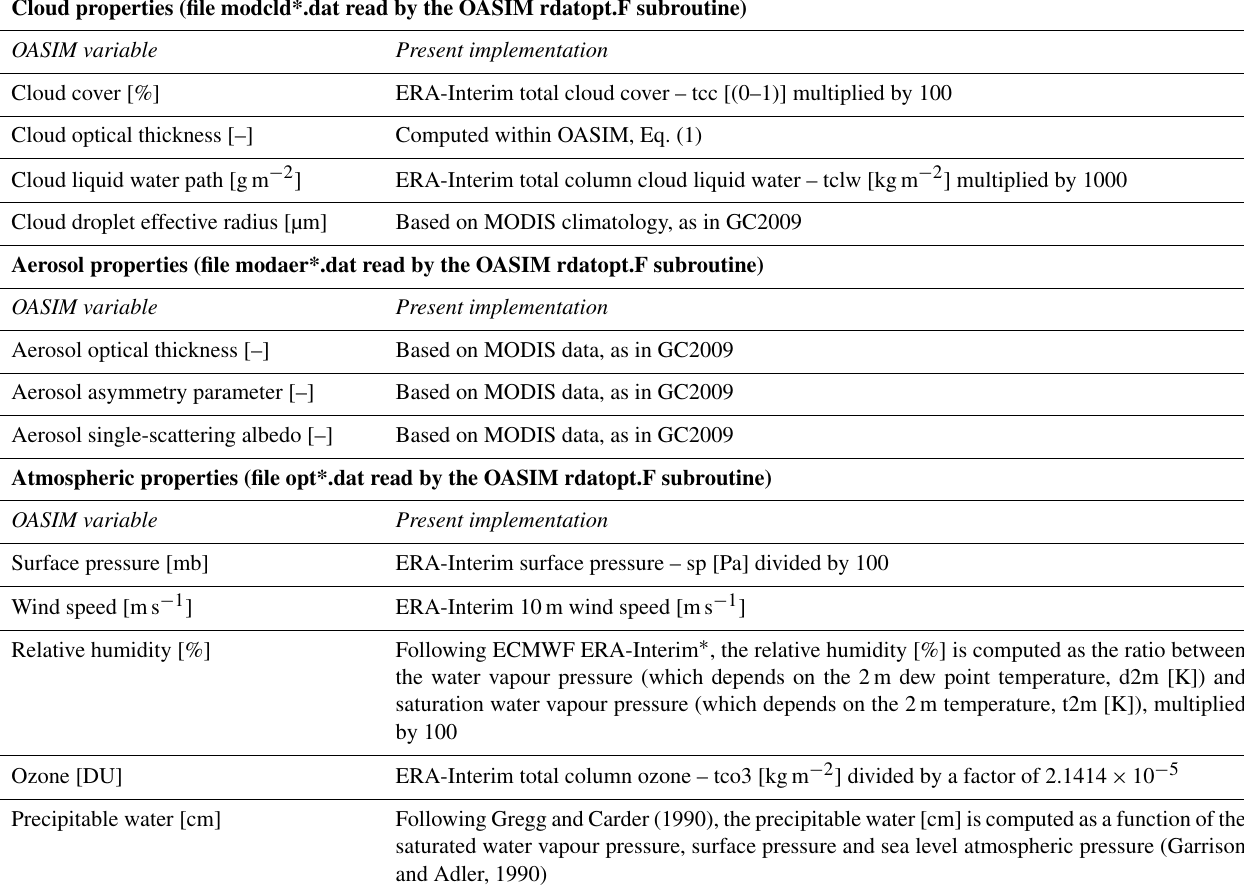
Table B1. Correspondence between the input variables required in OASIM (left column) and the implementation in the Mediterranean Sea (right column), with specific pre-processing